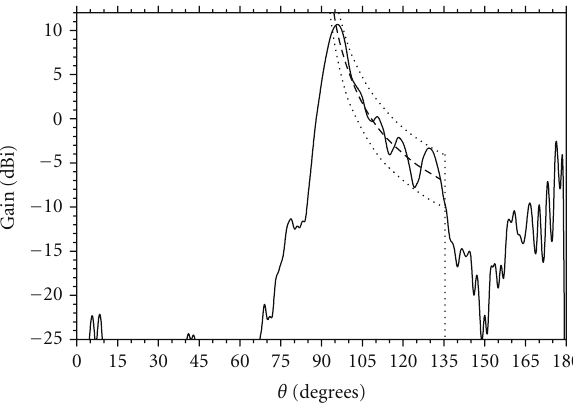
Figure 3: Sub- and main-reflector generatrices of the OADC antenna of Case I.